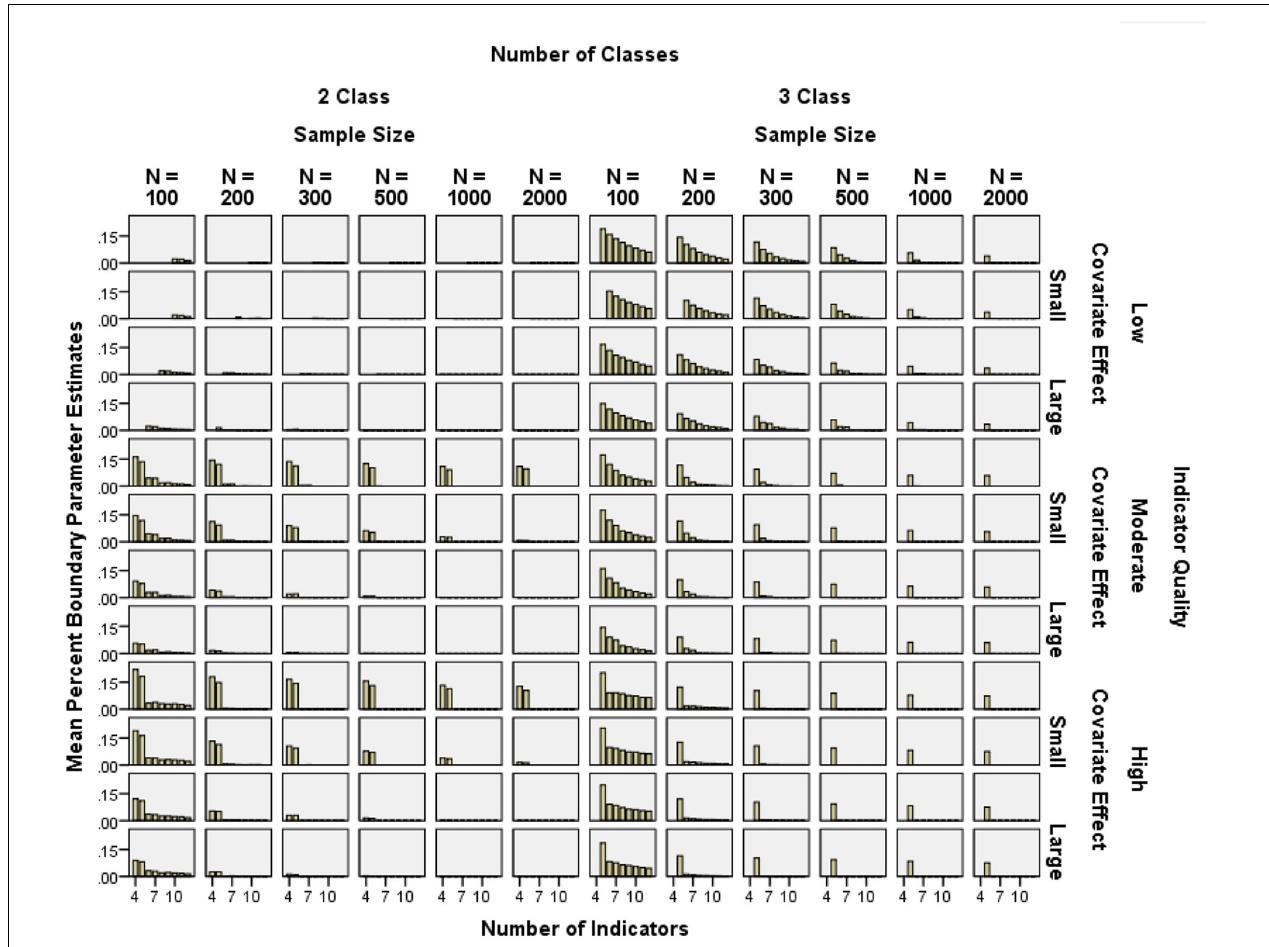
FIGURE 4 | Mean percent of boundary parameter estimates by sample size, number of indicators, indicator quality, and covariate effect